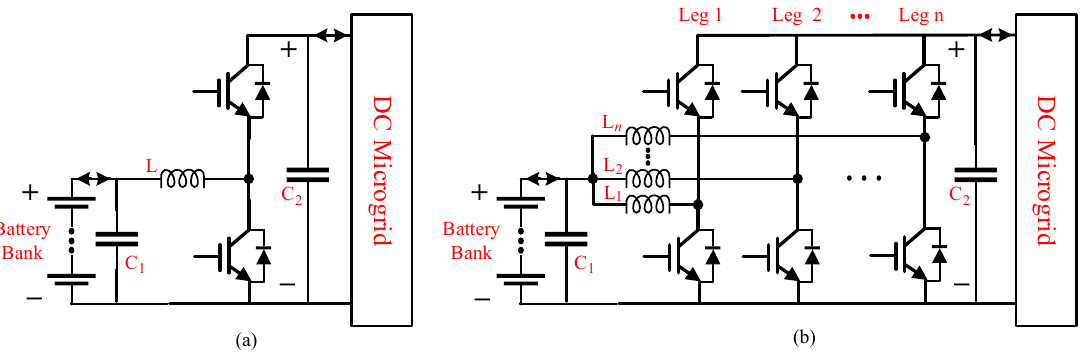
Figure 1. Bidirectional DC–DC converter for BESS connected to DC microgrid. ( a ) Conventional topology; ( b ) interleaved multiphase topology.